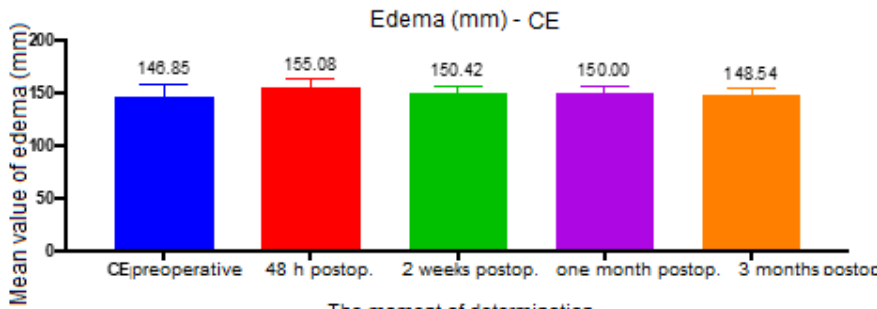
Figure 6. Edema assessment, CE distance.